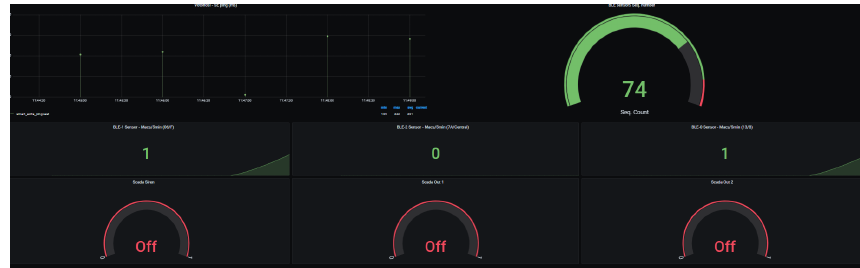
Figure 2. BL-detector real-time detection visualization web